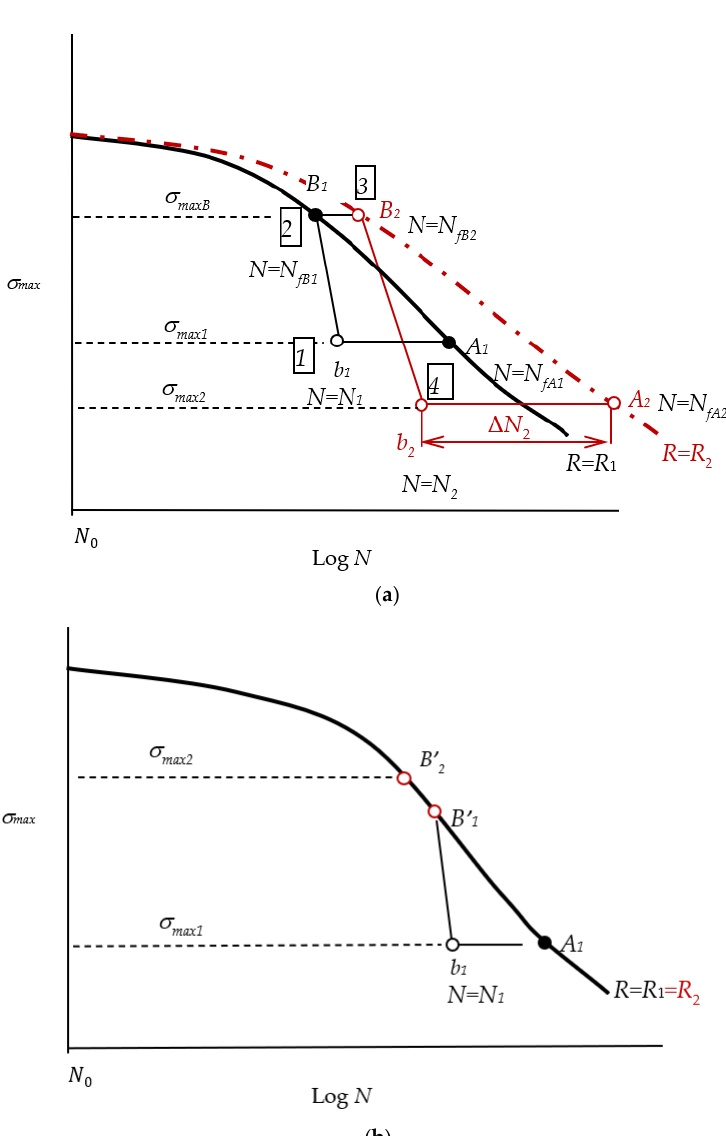
Figure 1. Loading schemes: ( a ) two S-N curves for the general case for changing stress from σ max 1 with R = R 1 to σ max 2 with R = R 2 ; and ( b ) a single S-N curve as a special case for an exception, where the iso-damage point does not correspond to that at the new stress level σ max 2 when low-high loading is applied.